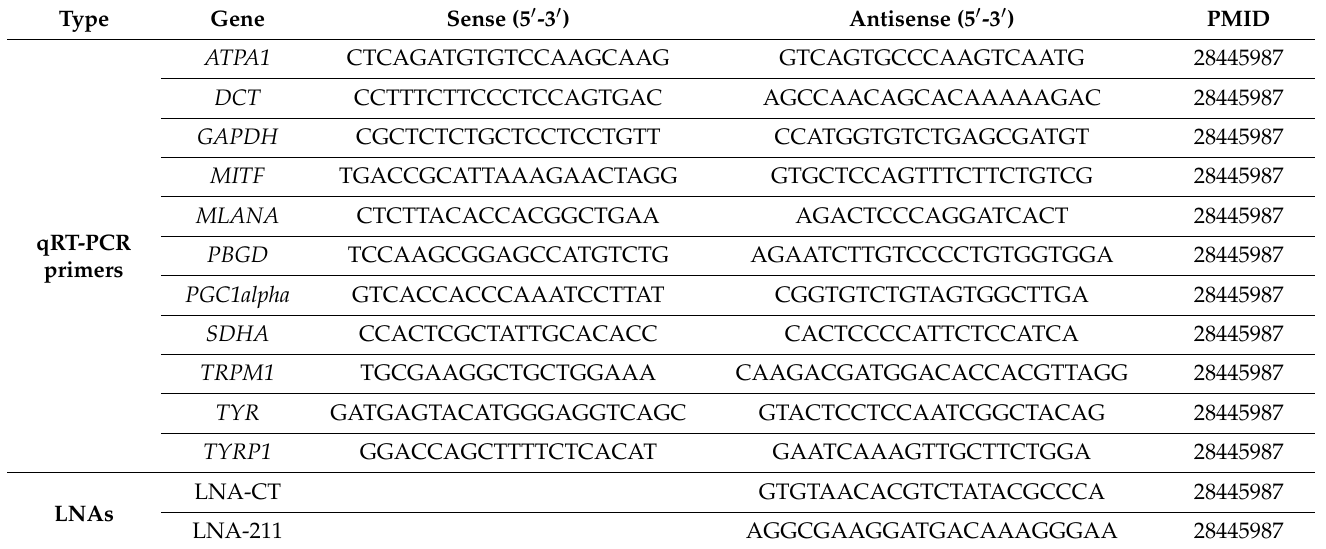
Table 1. Sequence of qRT-PCR primers and